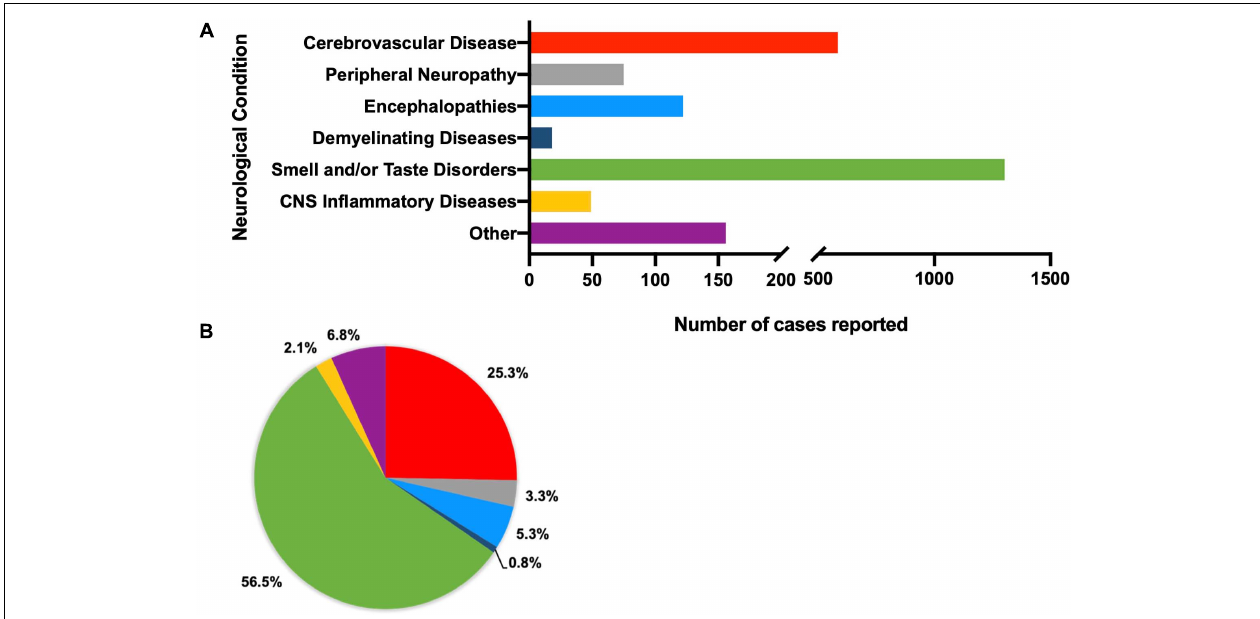
FIGURE 2 | Total number (A) and percent of (B) reported neurological conditions occurring in patients, regardless of demographics (total n = 2,390). Individual diagnoses have been categorized as cerebrovascular diseases ( n = 592), peripheral neuropathies ( n = 75), encephalopathies ( n = 175), demyelinating diseases ( n = 23), smell and/or taste disorders ( n = 1,303), CNS inflammatory diseases ( n = 45), and other (neurological symptoms that cannot be attributed to a specific neurological condition, such as headache, seizure, ataxia, aphasia) ( n =